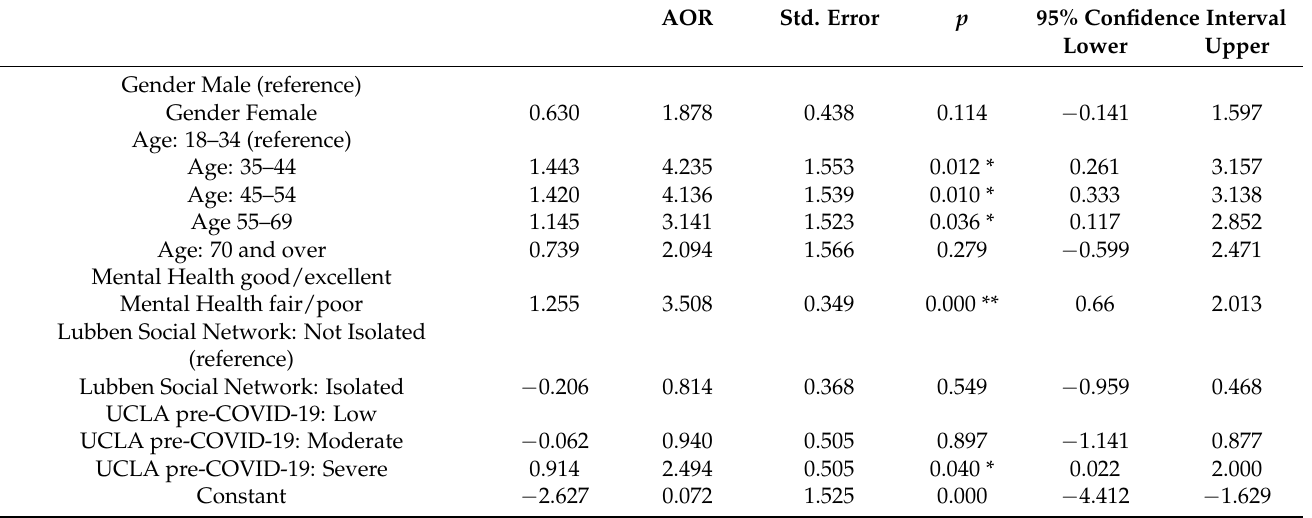
Table 6. Predictors of burden ( n =